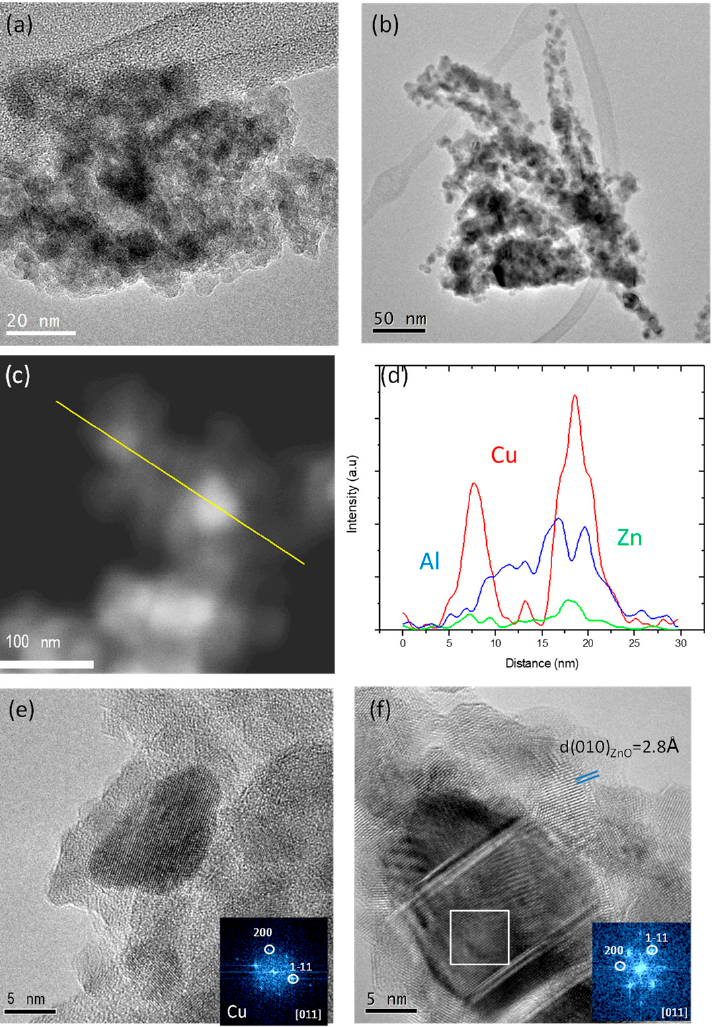
Figure 3. TEM micrographs of CZA_30 ( a ) and CZA_60 ( b ); TEM-HAADF micrograph of the CZA_30 sample ( c ) and EDX line profile ( d ). HRTEM images of a Cu particle and its corresponding FFT (fast Fourier Transform) in the inset of CZA_30 ( e ) and CZA_60 ( f ). Figure 4a,b show the elemental distribution of Cu, Zn, and Al from EDX maps, pointing out a heterogeneous dispersion of the three phases in both samples.